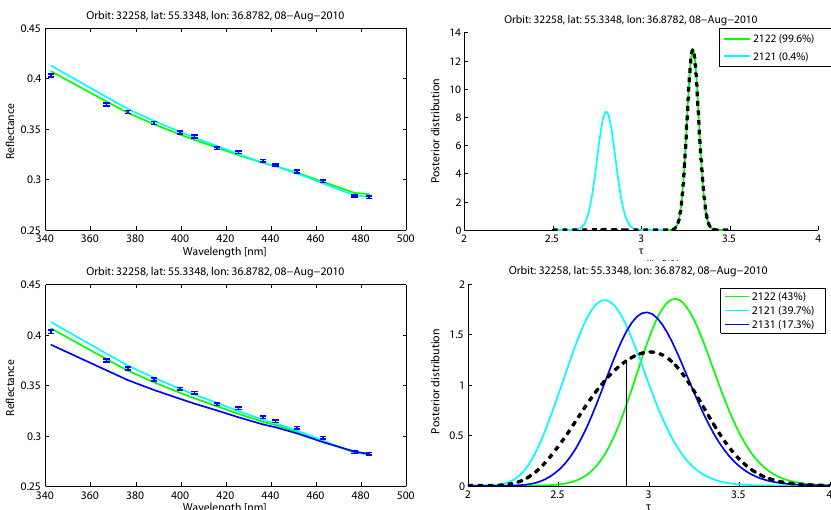
Fig. 7. Wild fires in Moscow, 2010. Upper row: the best two models when the model discrepancy is not included. Bottom row: the best three models when the model discrepancy is included. Also see Fig. 5. The AOT_500 from AERONET is near the mode, i.e. the maximum point, of the averaged posterior as can be seen from the black vertical line (bottom right